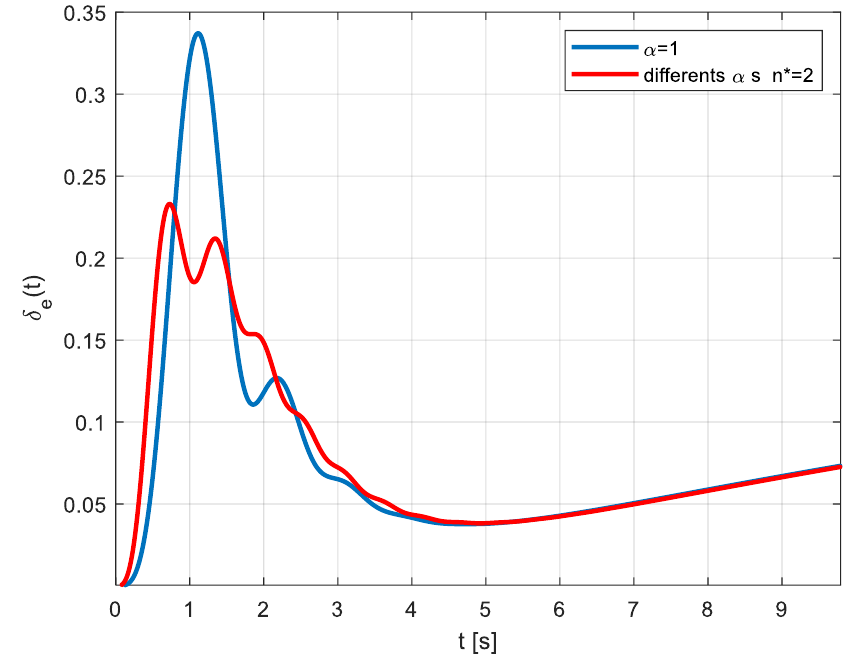
Figure 14. Zoom of the control effort δ e ( t ) with FO-DMRAC and IO-DMRAC.